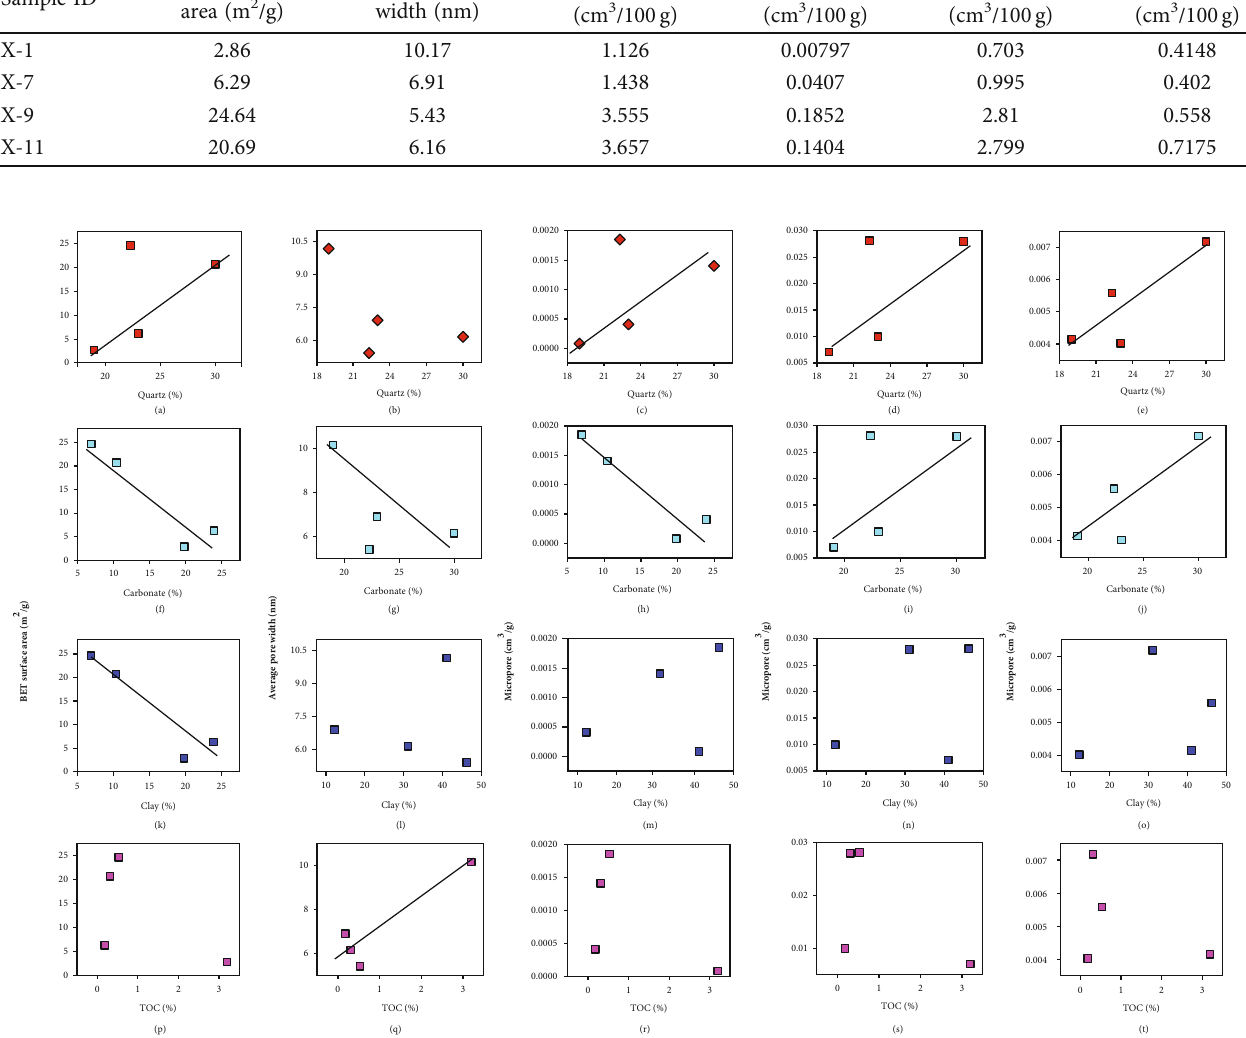
Figure 6: Cross-plots for mineral controls on the development of shale reservoir